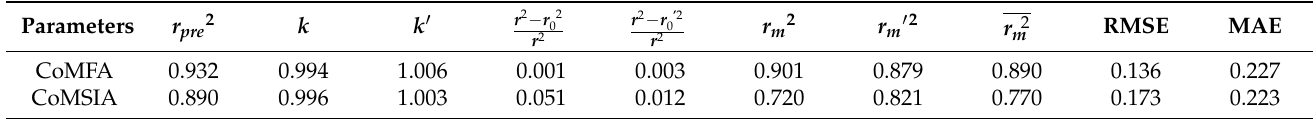
Table 2. External validation parameters of the 3D-QSAR models.